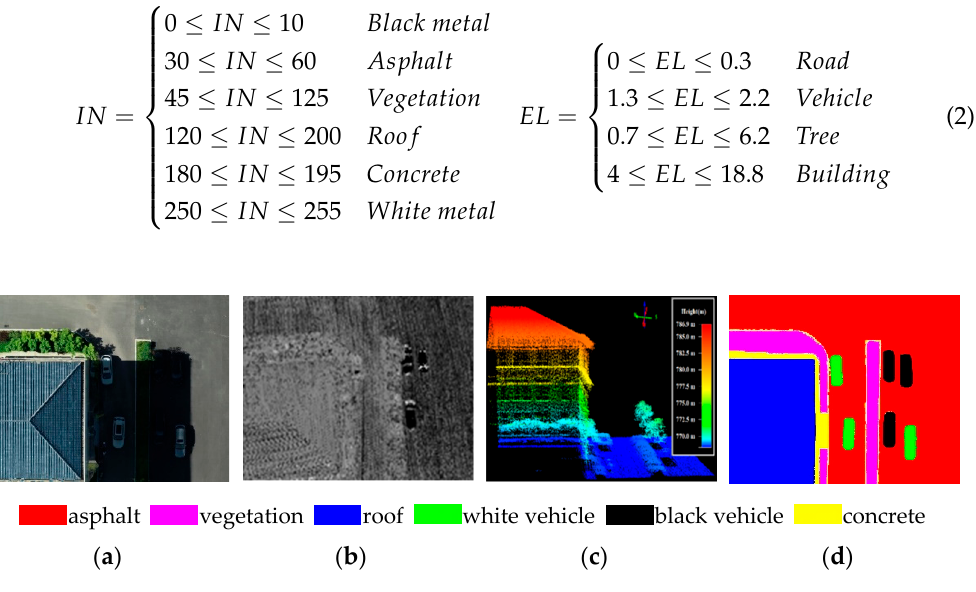
Figure 3. Segmentation processing of homogeneous regions: ( a ) UAV RGB image; ( b ) LiDAR intensity image; ( c ) LiDAR point cloud data; ( d ) Segmentation results.